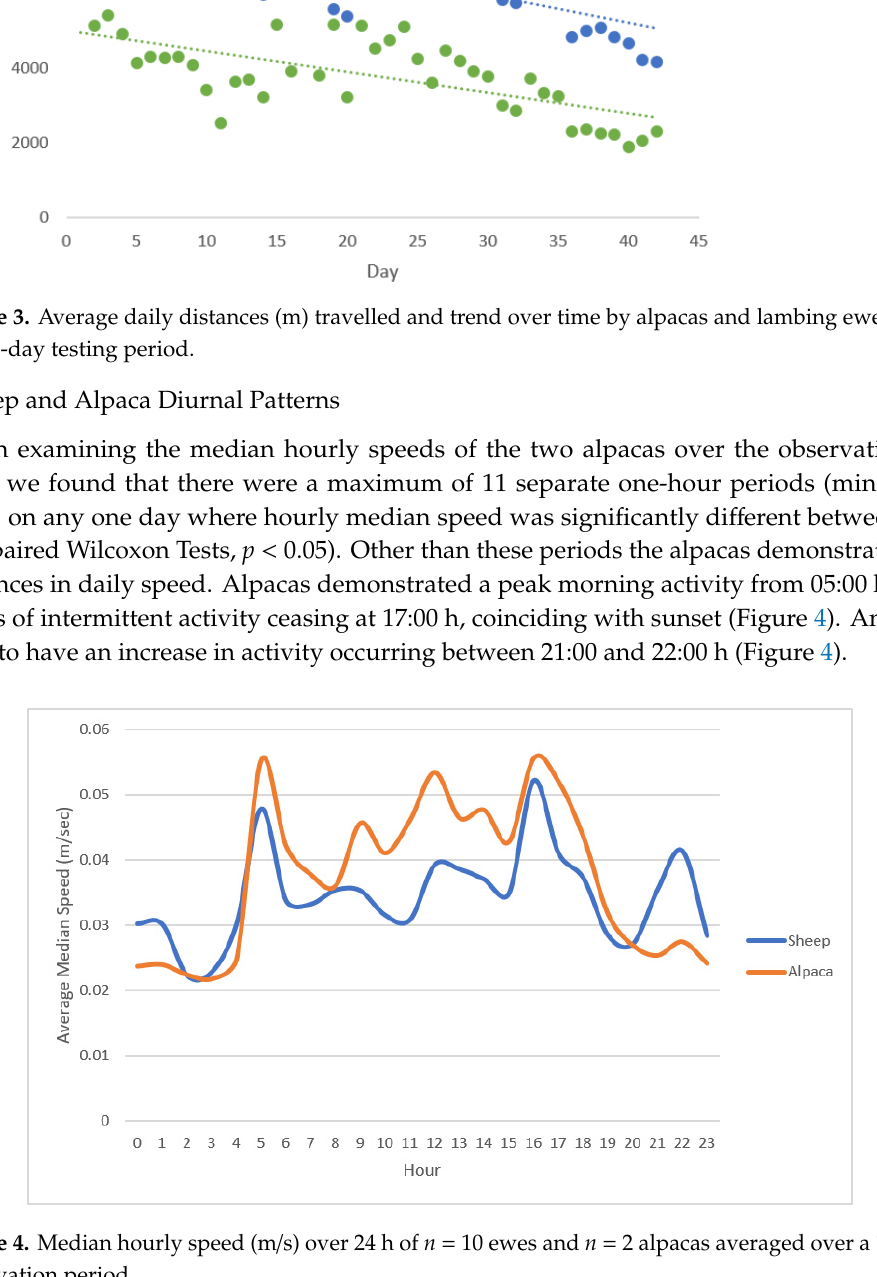
Figure 5. Livestock residency index maps for ewes and alpacas from 22/10/17 to 31/10/17. ‘Day’ was considered to be 06:00–19:00 h while ‘Night’ was 20:00–05:00 h. ( a ) ewe day; ( b ) alpacas day; ( c ) ewe night; ( d ) alpacas night. Dark blue grids indicate areas of heaviest stock density residency and green represents areas of lowest stock density residency.